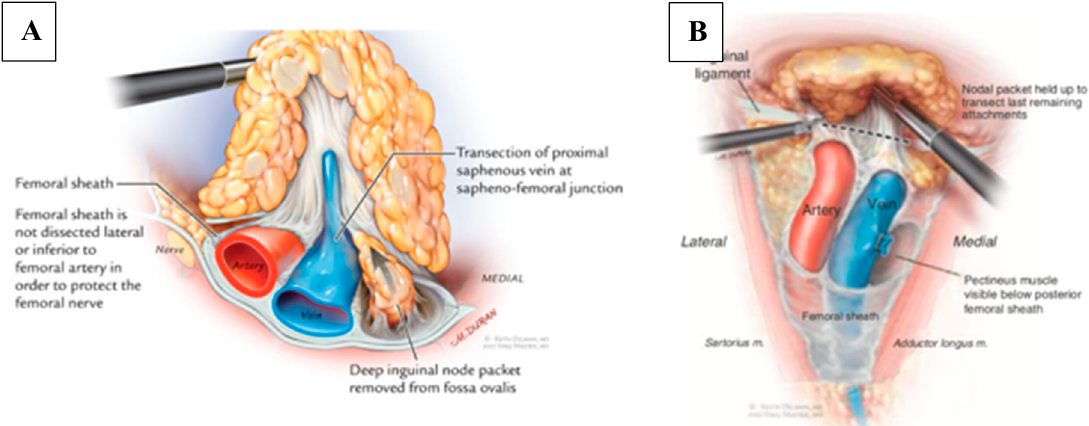
Figure 5. ( a ) Dissection is carried in caudal to cephalad direction. Assistant can lift the nodal packet and allow the surgeon to carry dissection above the vessels. ( b ) All remaining attachments are freed in preparation for nodal retrieving. Copyright owned by Master et al.